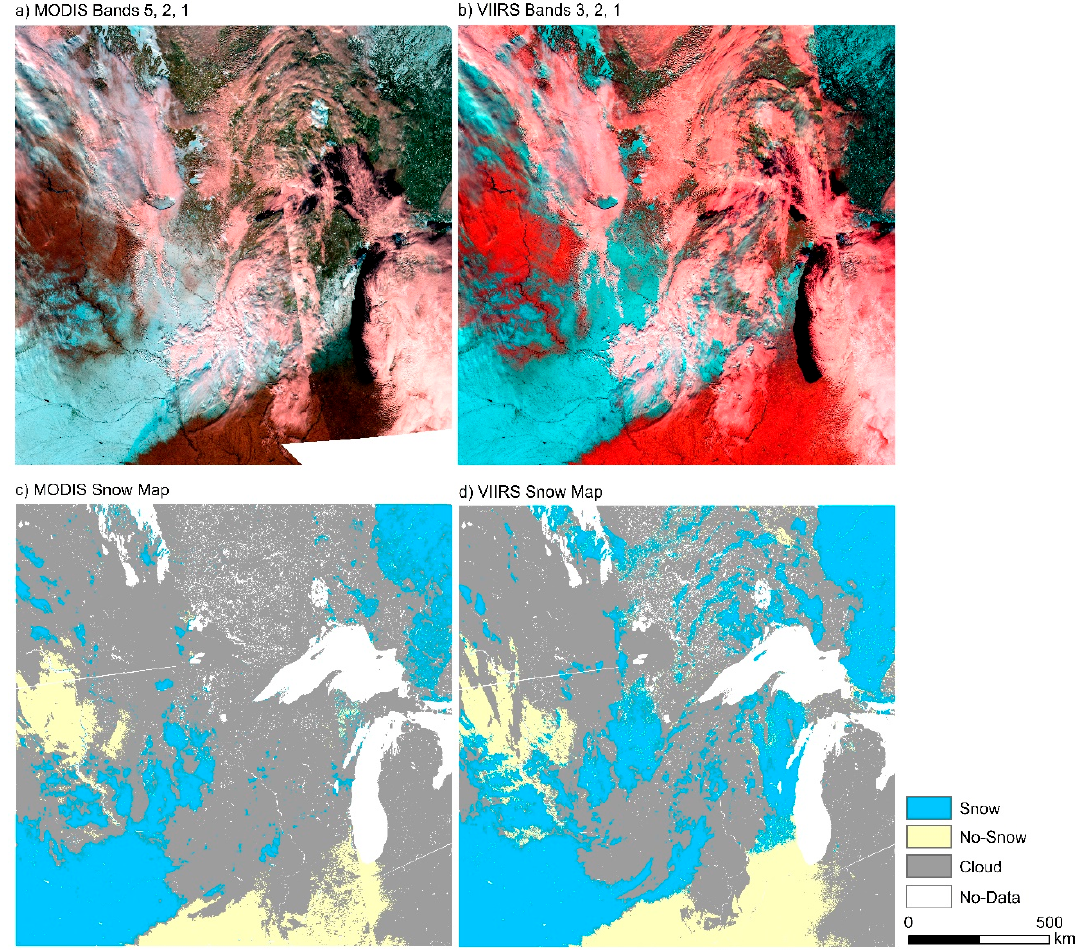
Figure 10. Qualitative comparison during 4 Feburary 2016. ( a ) A false-color composite image of MODIS bands 5 (1230–1250 nm), 2 (841–876 nm), 1(620–670 nm) as R, G and B that shows snow as cyan colors; ( b ) a false-color composite image of VIIRS bands I3 (1580–1640 nm), I2 (846–885 nm), I1 (600–680 nm) as R, G and B as R, G and B that shows snow as cyan colors; ( c ) MODIS binary snow map and ( d ) VIIRS binary snow map.